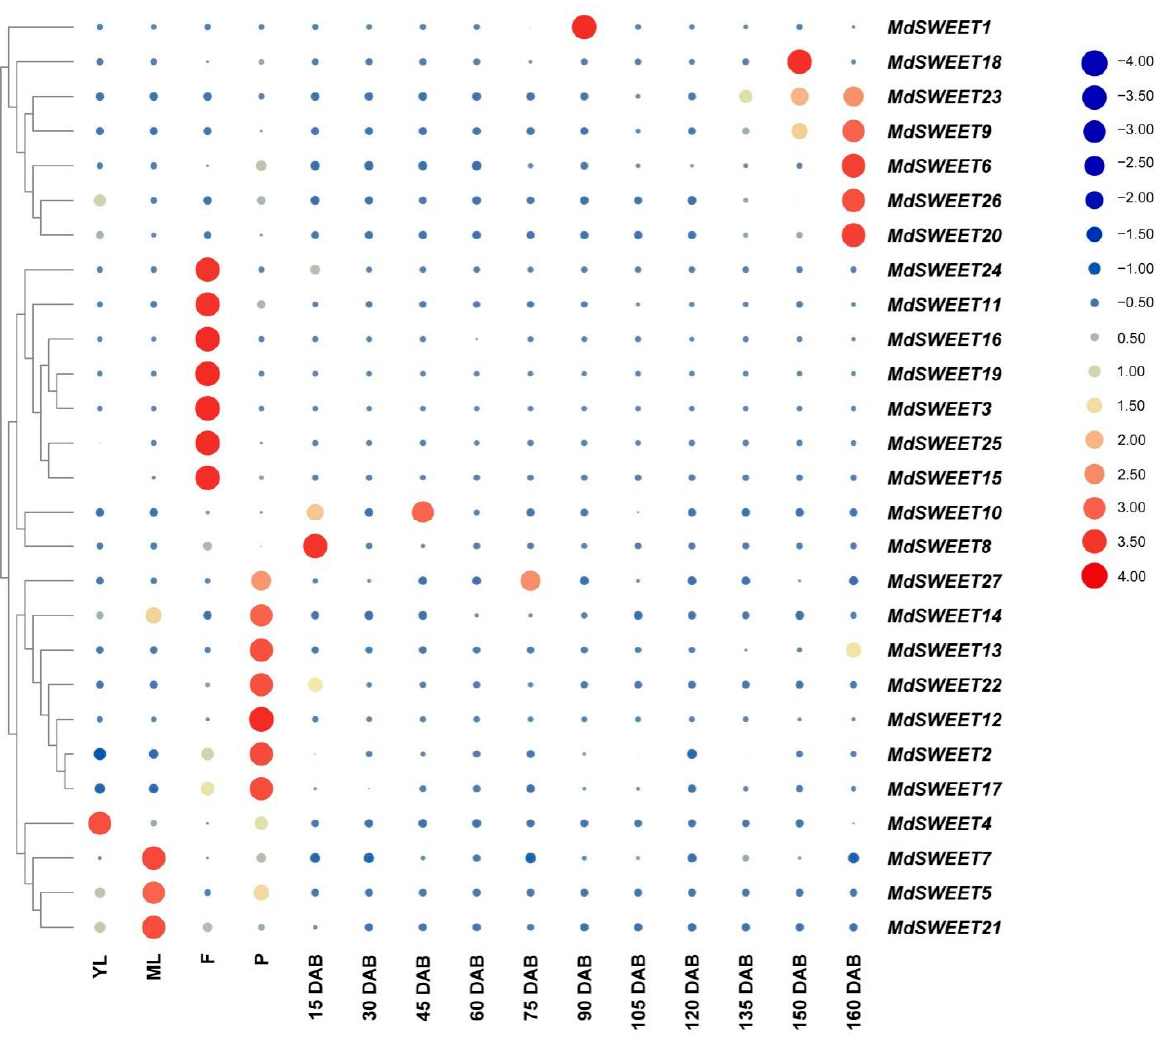
Figure 7. Expression heatmaps of SWEET genes in four tissues/organs and eleven different fruit development stages. Relative mRNA expression was measured using qRT-PCR. MdSWEET expression data were normalized and the heatmap was generated using the Tbtools V1.075 software. YL indi- cates young leaf; F indicates flower; P indicates peduncle; ML indicates mature leaf; DAB indicates days after